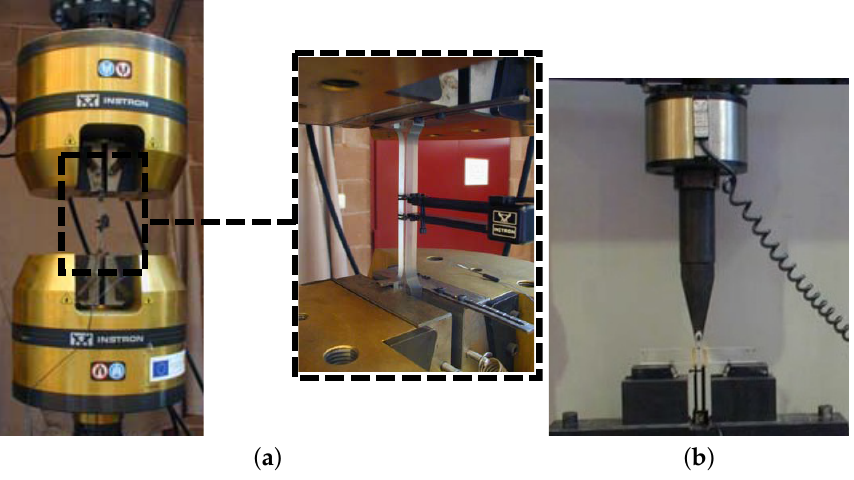
Figure 1. Experimental set-up for ( a ) uniaxial tension test and ( b ) fracture toughness test. The true stress-true strain curves obtained from the uniaxial tension test are repre- sented in Figure 2, from where the values of Young’s Modulus and tensile strength are obtained. These mechanical properties are in agreement with the experimental results reported by other authors [23,50–52].